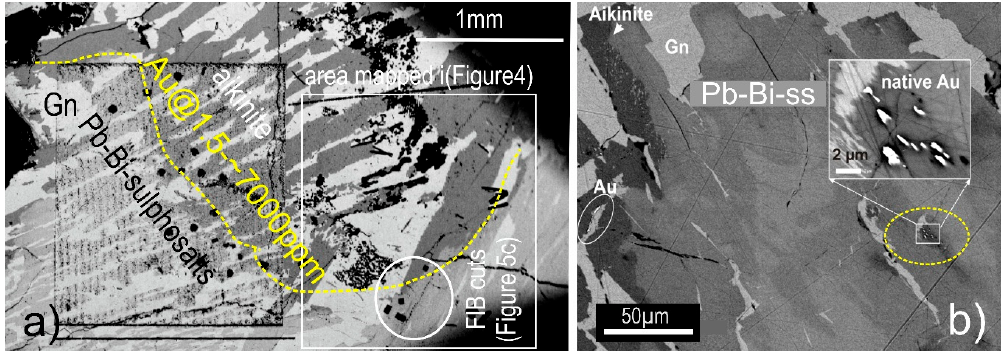
Figure 2. Back Scatter Electron (BSE) images showing aspects of the Au-rich boundary along the reaction front, in which there is a sharp change from aikinite to Cu-Ag-bearing Pb-Bi-sulphosalts. Galena (Gn) is present in the matrix. ( a ) Gold concentrations (yellow) along the front from laser ablation inductively coupled plasma mass spectrometry (LA-ICP-MS) data [90]; ( b ) Detail showing inclusions of native gold along the reaction front correlating with Cu-enrichment (darker shades) in the Pb-Bi-sulphosalts.